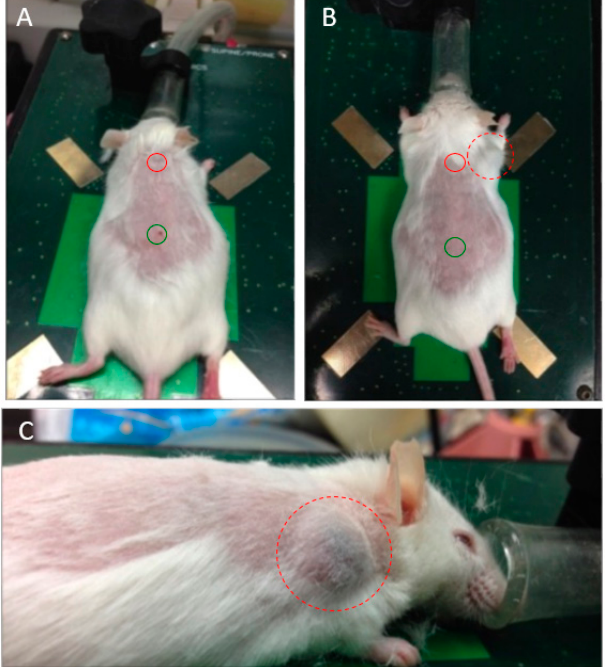
Figure 6. Tumorigenesis after injection of captured CTCs. ( A ) Eluted CTCs from the mCMx system were subcutaneously injected into a non-tumor-bearing mouse at the site between the scapulars (red circle), and a control medium was injected 5 cm caudally (green circle). ( B ) Three weeks later, a tumor was found 1 cm from the inoculated site (dashed red circle). ( C ) Profile view of the tumor.